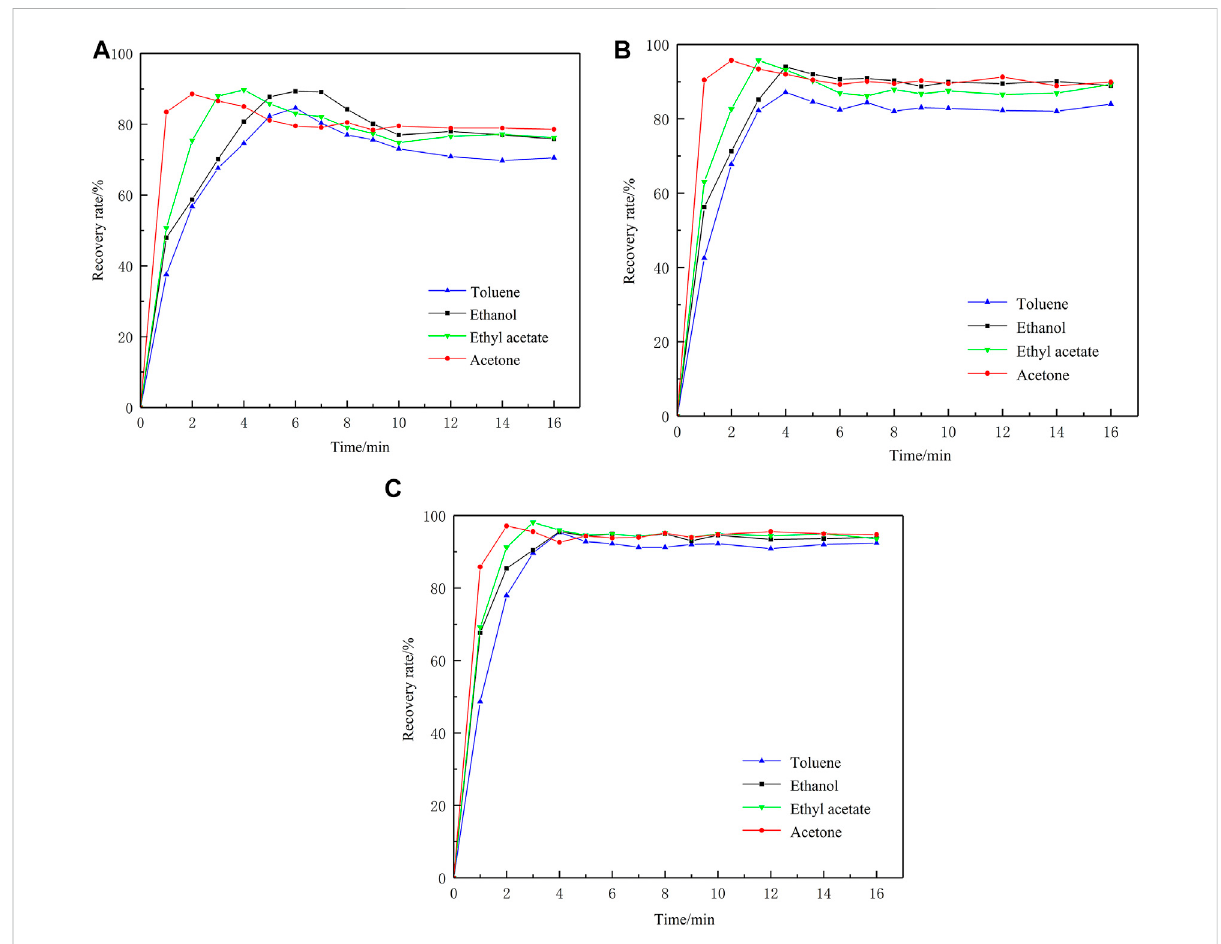
FIGURE 2 Adsorption effects in airbags made of PET (A) , PVF (B) , and PTFE (C)